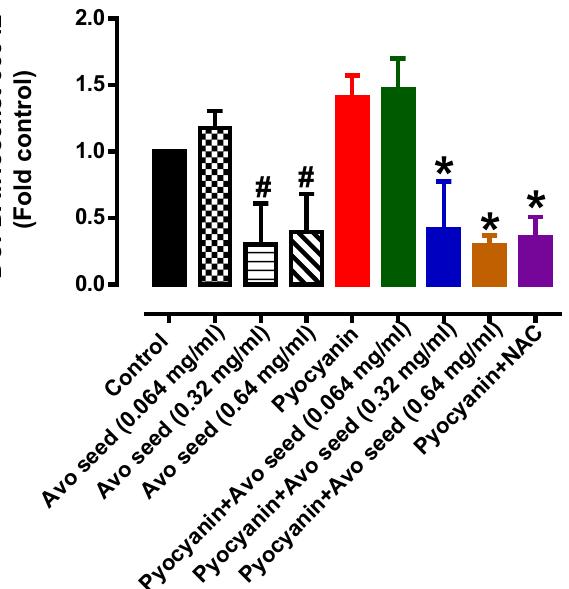
Figure 5. Intracellular reactive oxygen species measurement of avocado seeds extracts treatment of HMEC-1 cells under basal and pyocyanin-induced oxidative stress. # Significantly different to control; * Significantly different to pyocyanin, P < 0.05, (1-way ANOVA, Tukeys’s post-hoc test). Data is presented as mean ± SD, n =